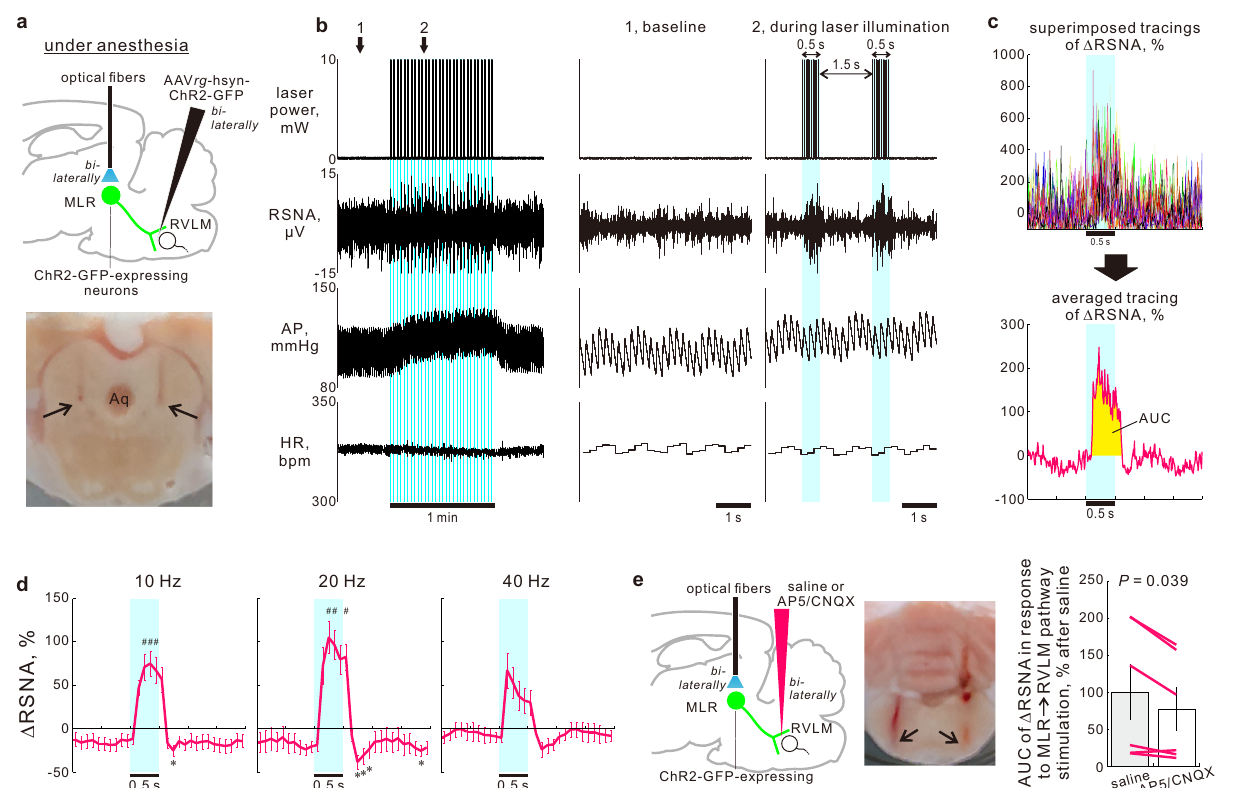
Fig. 2 | MLR → RVLM pathway drives sympathoexcitation. a Optogenetic sti- mulation of MLR → RVLM neurons in anesthetized rats. Arrows: locations of optic- fi ber tips. b Representative recording during optogenetic stimulation (20Hz) in a ChR2-GFP-expressing anesthetized rat. Aqua blue-colored backgrounds indicate illumination periods. c Superimposing and averaging analysis performed on RSNA shown in panel b . Time courses (10-ms bins) of percentage changes in RSNA from the baseline (= 30-s averaged value before the fi rst optogenetic intervention) during each cycle (upper) were averaged at each time point over 30 interventions (lower). d Time courses (100-ms bins) of Δ RSNA, after superimposing and aver- aging analysis, in response to intermittent MLR → RVLM neuron stimulation in ChR2-GFP-expressing anesthetized rats [ n =9 (7 males, 2 females) besides n =7 (5 males,2females)at10Hz]. e EffectofglutamatereceptorblockadesintheRVLMon RSNA response to MLR → RVLM neuron stimulation (20Hz) in ChR2-GFP-